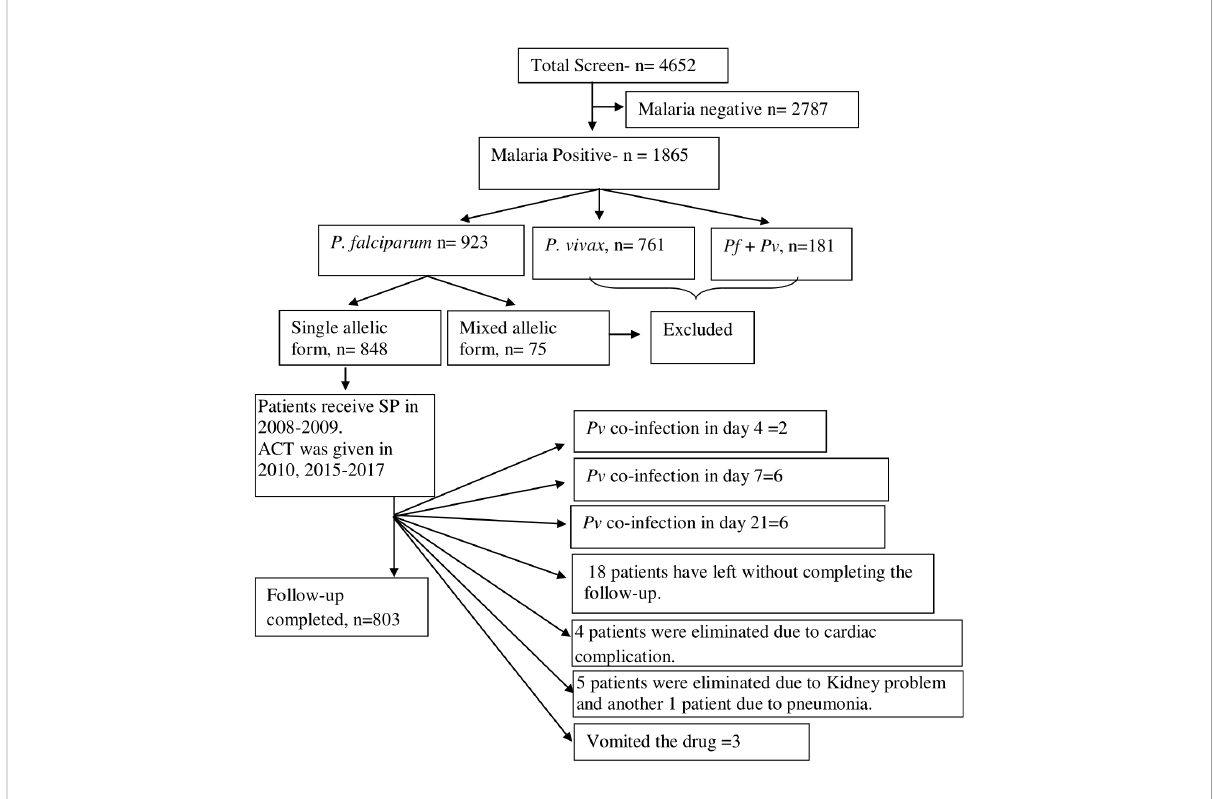
FIGURE 1 Schematic presentation of patient selection and details inclusion and exclusion criteria for the study. Out of 4,652 screened patients, 2,787 (60.34%) patients were eliminated as they had shown malaria slide negative. A total of 923 patients (19.41%) were found with P. falciparum infection. Of them, 75 isolates (8.64%) were identi fi ed as mixed P. falciparum infection and they were eliminated as these isolates contained both mspI and mspII alleles. Forty- fi ve patients had not completed the 28-day treatment follow-up, and they were eliminated from the